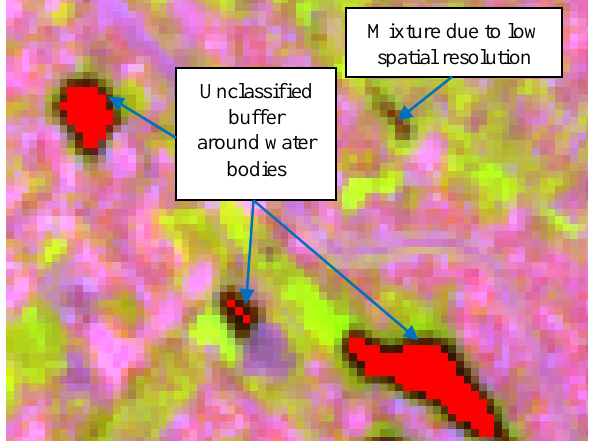
Figure 11. Influence of spatial resolution to accuracy of water